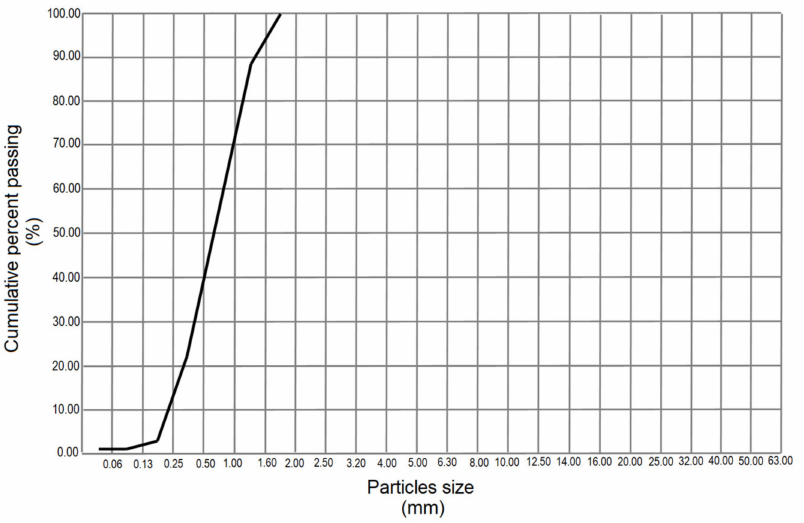
Figure 6. Granulometric curve of natural zeolite particles passed through the filler. The specific surface area (BET) on the investigated mordenite was 66 m 2 /g with an initial particle diameter of 2.88 µ m and another final diameter equal to 139.25 µ m. The average value was 54.76 µ m which turned out to be quite close to that of Blaine